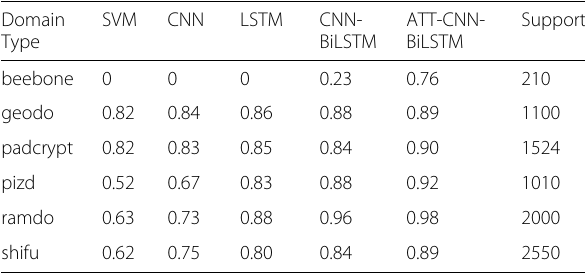
Table 2 The detection result of unknown DGA families Domain Type